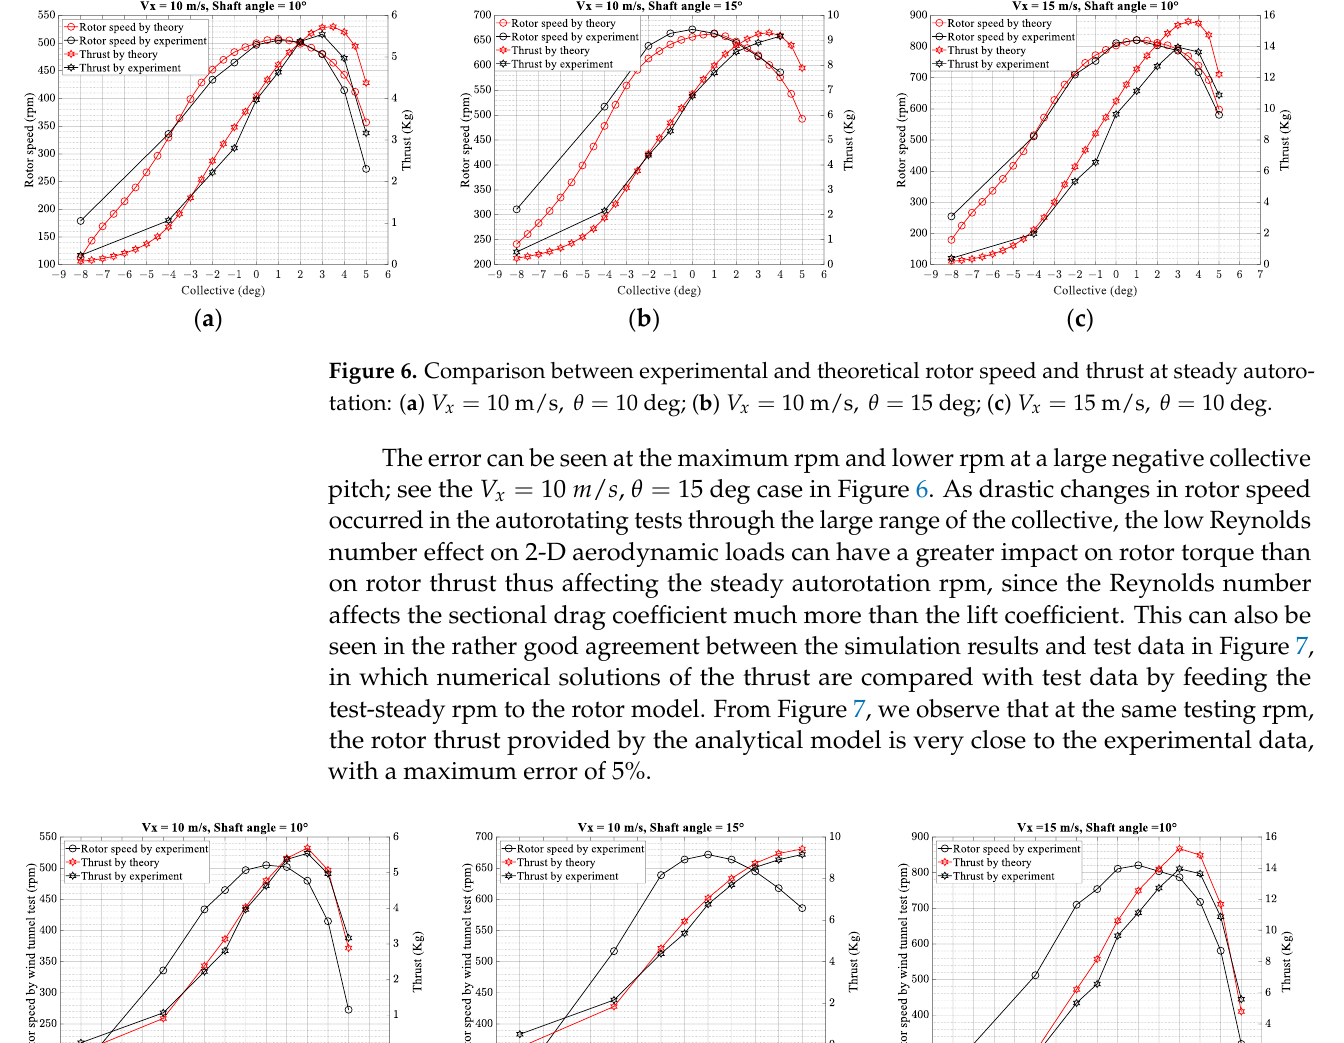
Figure 7. Comparison between experimental and theoretical thrust at steady autorotation (both thrust curves are at test-steady rpm): ( a ) V x = 10 m/s, θ = 10 deg; ( b ) V x = 10 m/s, θ = 15 deg; ( c ) V x = 15 m/s, θ = 10